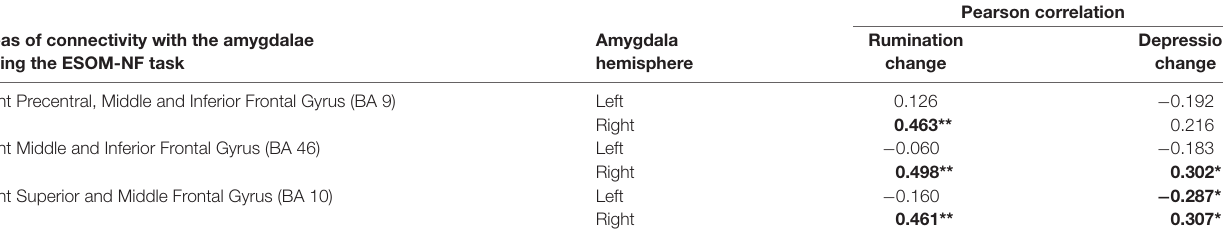
Pearson correlation